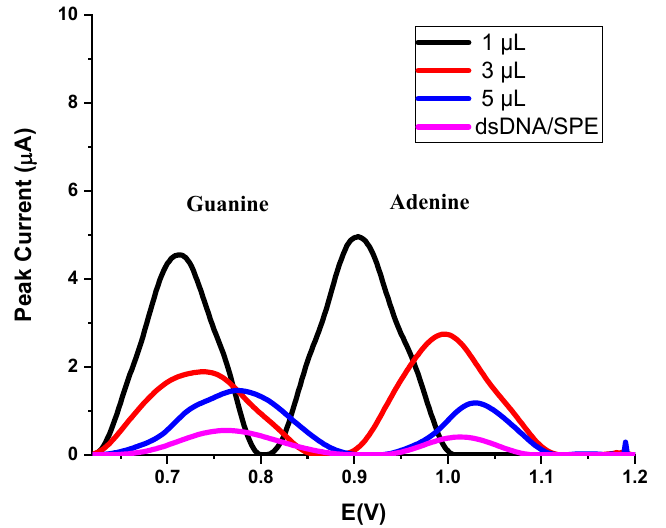
Figure 3. DP voltammograms at dsDNA/SPE (pink), dsDNA/PtNPs/AgNPs/SPE with different casting volume of PtNPs in pH 4.70 AB; 1 µ L (black) 3 µ L (red) 5 µ L (blue). Table 2. The comparison of dGuo and dAdo signals in pH 4.70 AB by DPV at various AgNPs volume of modified electrodes. dGuo dAdo Electrode